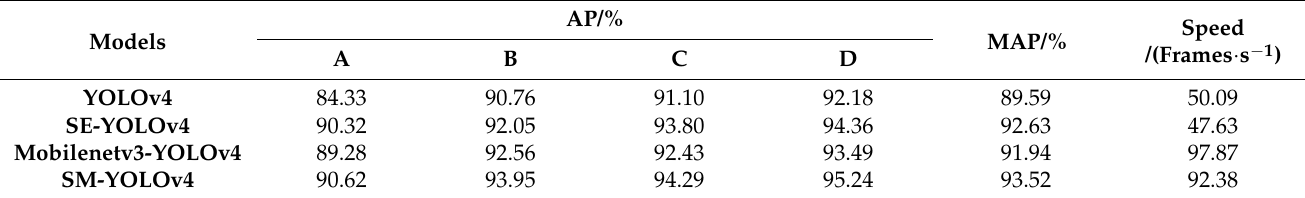
Table 2. Comparison of the training results of the modified network